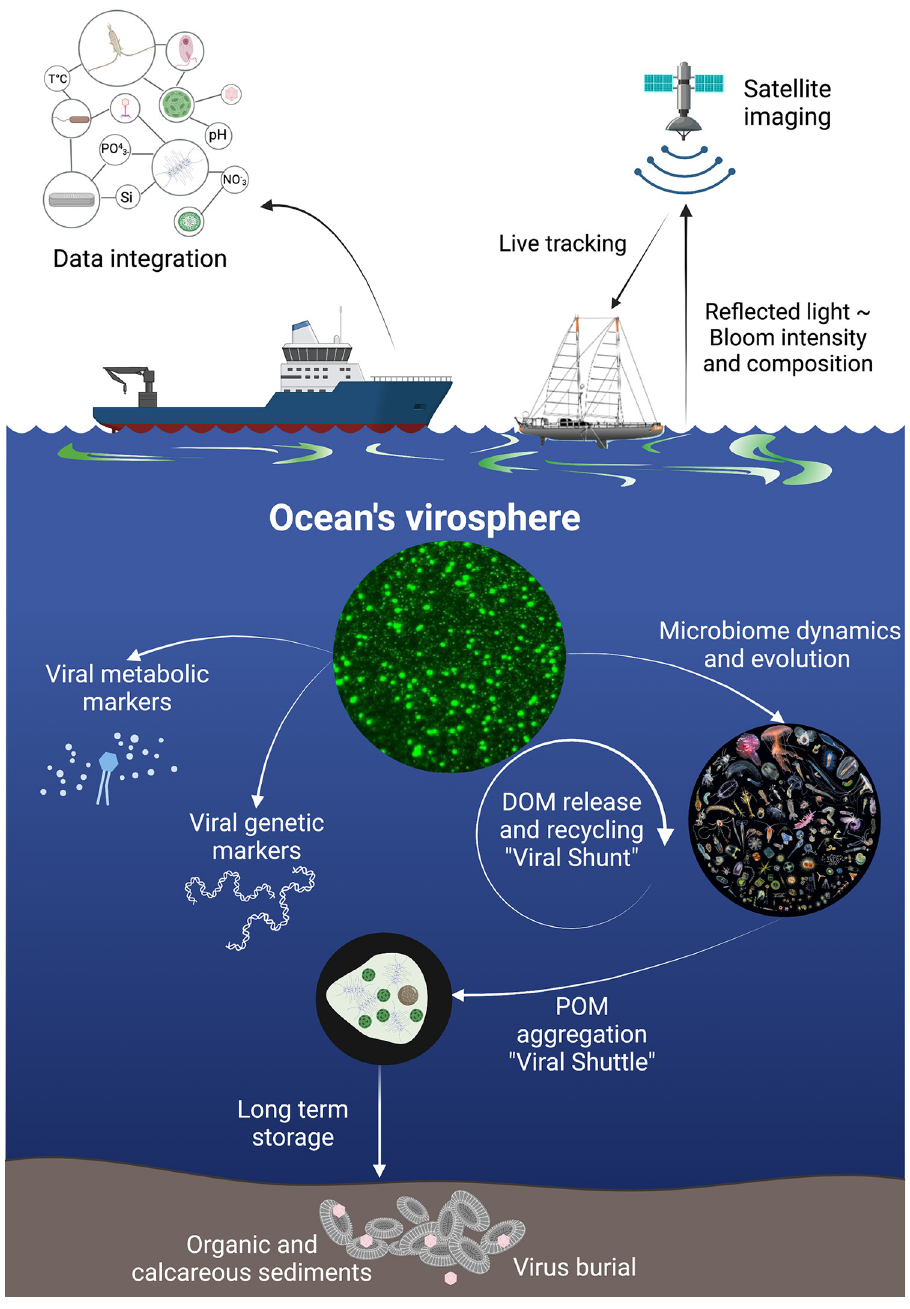
Fig 2. Assessing the impact of viruses at the macroscale. To study the impact of viral infection at large spatiotemporal scales, algal blooms can be detected by remote sensing to guide in situ field experiments. Following the dynamics of viral infection in the ocean can be done by using metabolic and genetic markers coming from lab-based studies, in an attempt to better characterize the “viral shunt” and its consequences on both bacterial and protist successions. Finally, across vertical gradients from surface to depth, quantifying the consequences of viral infection on the aggregation and sinking of infected algae particles will contribute to a better understanding of the “viral shuttle,” including the burial of sediments and virions along geological timescales. DOM, Dissolved Organic Matter; POM, Particulate Organic Matter. Credit: Ocean’s virosphere from Jed Fuhrman (CC BY2.5); plankton mandala with authorization from Christian Sardet. Created with